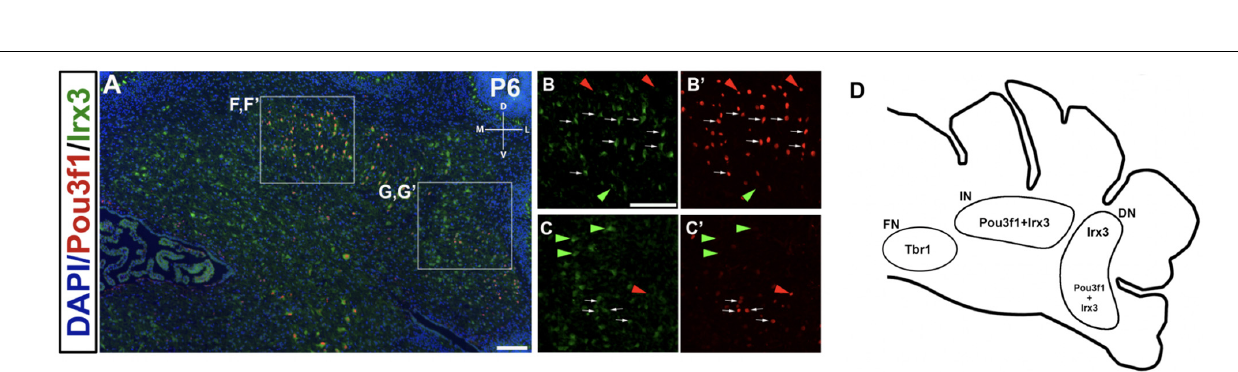
Frontiers in Molecular Neuroscience |